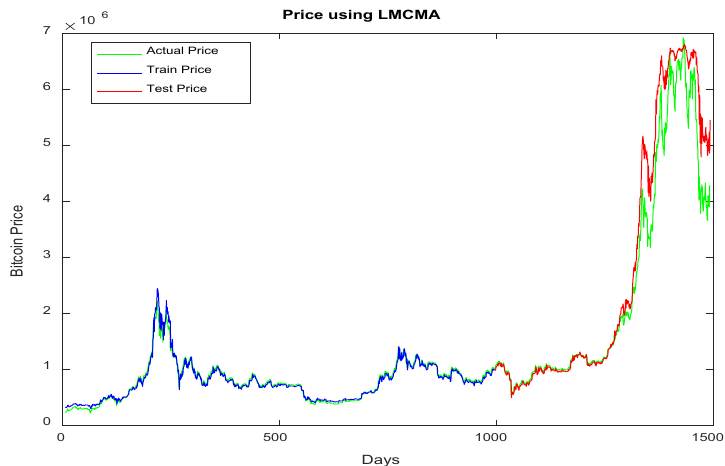
Figure 7. Bitcoin prices using CMCMA for BTC/JPY dataset.